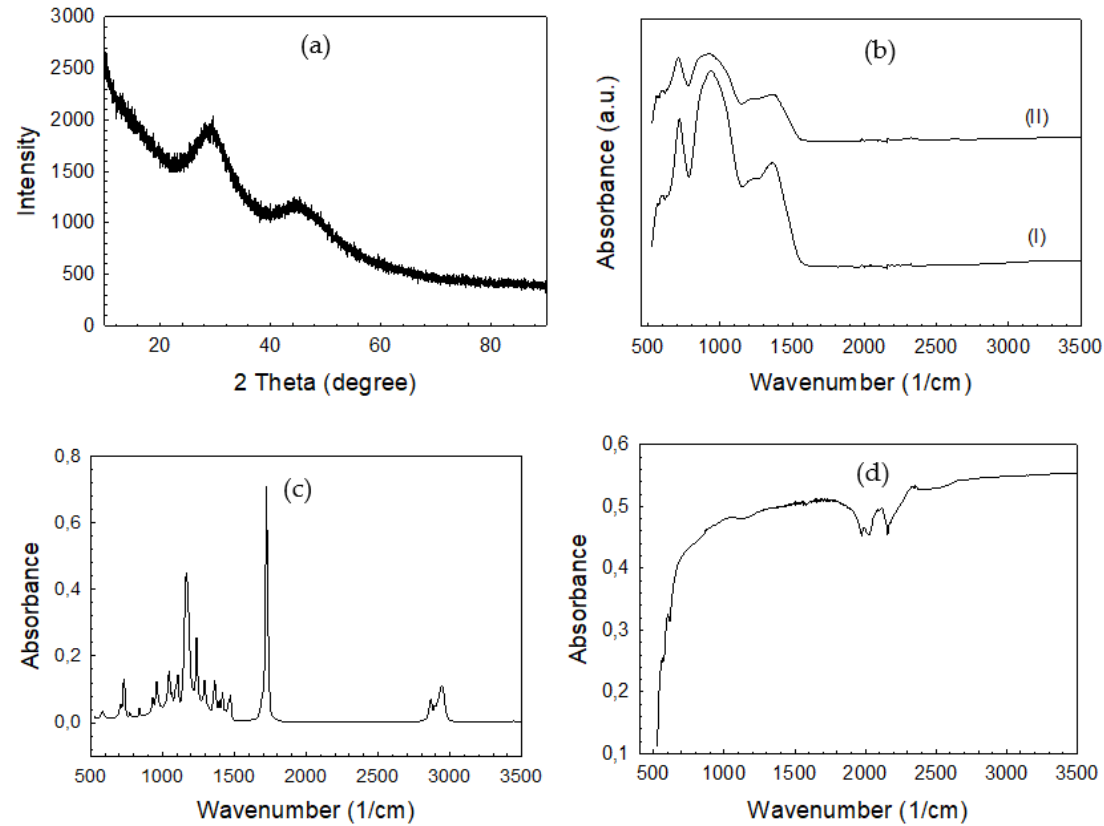
Figure 5. ( a ) XRD pattern of the sintered bare bioactive glass scaffold, ( b ) FTIR-ATR spectra of the bare borate glass (I) and PCL-coated borate glass scaffolds (II), ( c ) FTIR-ATR spectrum of the PCL, ( d ) graphene nanopowders utilized in the study.